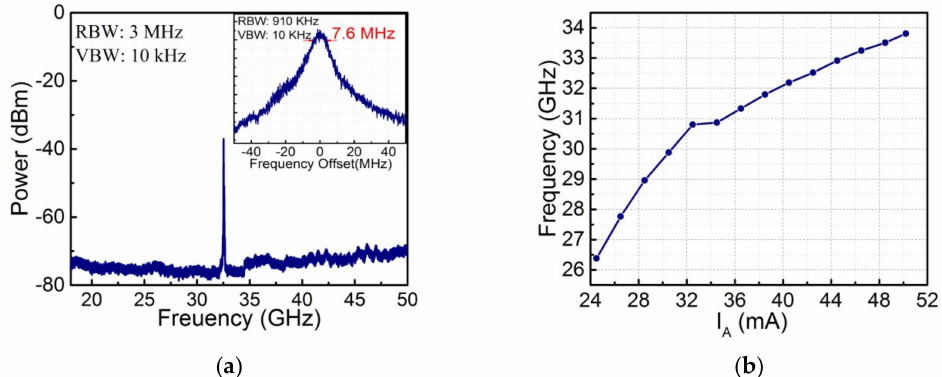
Figure 3. When V PD , I DFB, and I phase were fixed at − 2.5 V, 78 mA, and 3 mA, respectively, ( a ) the RF spectra with I A = 42.5 mA, Inset: 100-MHz zoom-in view; and ( b ) the beating RF frequency when I A varied from 24.5 mA to 50.5